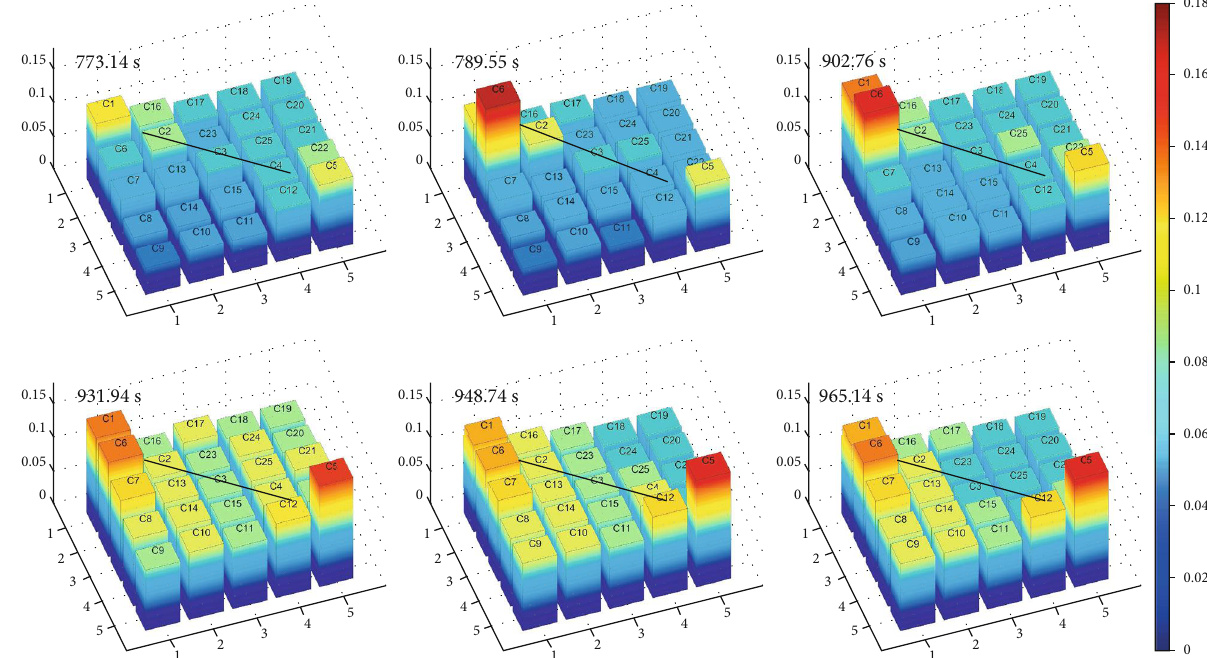
Figure 7: AIRT increment histogram under 30MPa before peak stress (black line indicates the prefabricated crack), reading from left to right and then up to the block ( t = 1074 : 61 s ), resulting in the temperature fi eld on the left side of the prefabricated fi ssure alternately rising from the top to bottom ( t = 1083 : 01 s − 1106 : 40 s ). The heat further radiates to the center of the rock ( t = 1125 : 32 s − 1144 : 51 s )